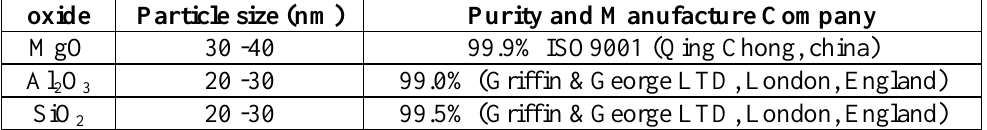
Table 1: The source, particle size and purity of raw material